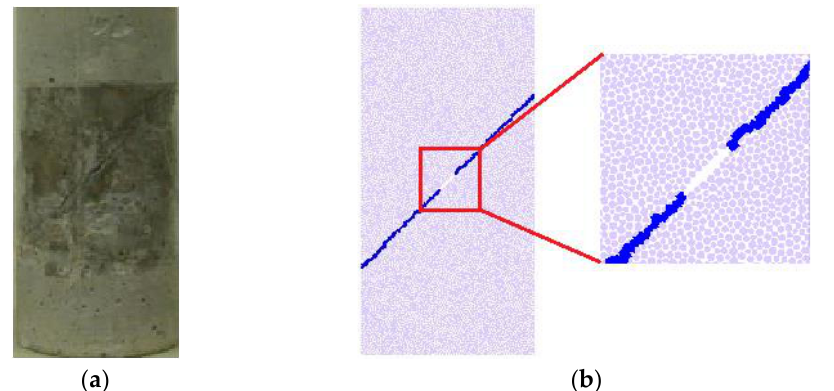
Figure 7. Real jointed rock mass specimen and numerical one: ( a ) real specimen; ( b ) numerical model.